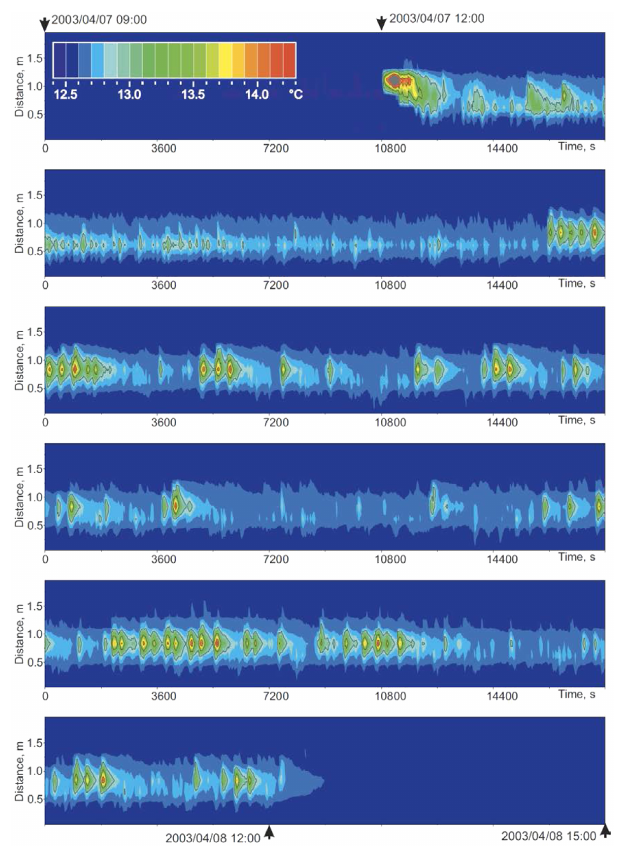
Figure 4. The temperatures 3h before, during, and 3h after the A5a heating experiment in space–time domain: temperature color-coded in ◦ C; on the vertical axis the locations of the sensors are shown on the horizontal 2m bar; temporal tick marks on the horizontal axis correspond to 3600s = 1h.